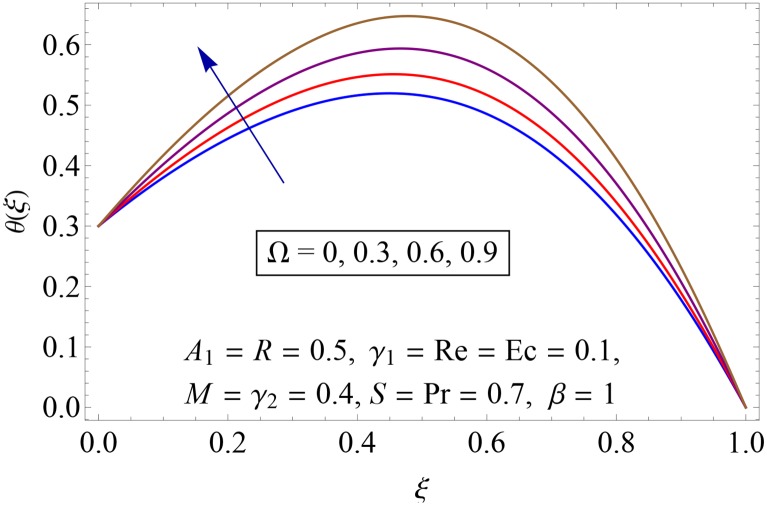
Impact of Ω on θ(ξ).